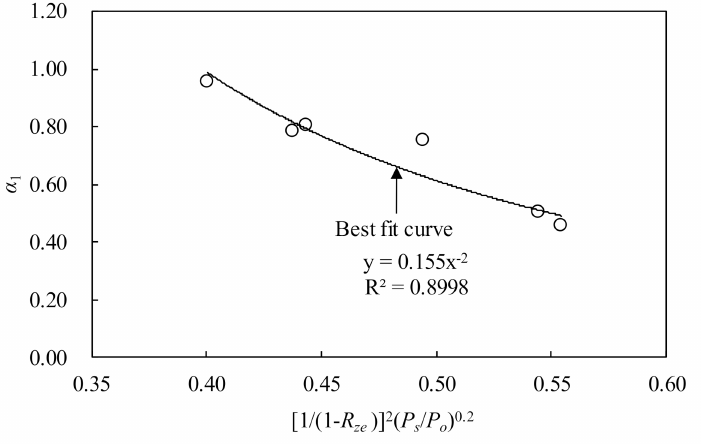
Figure 12. Regression analysis of α 1 in time